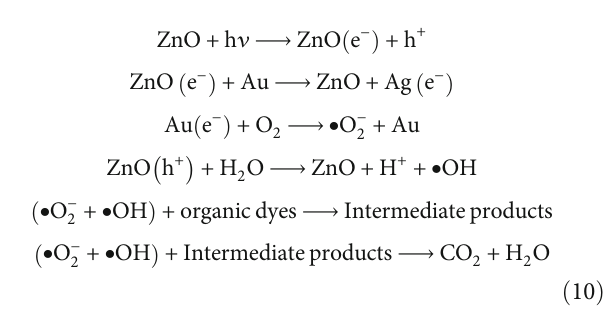
Figure 13: (a) E ff ect of initial H concentrations. The reaction conditions: catalyst dosage of 0.5g/L, TA concentration of 10mg/L, pH solution of 6.0, and Hg lamp